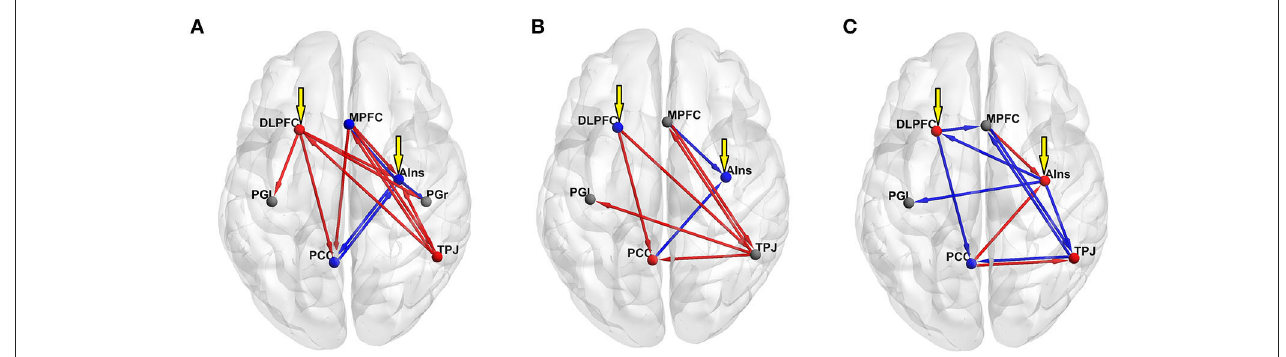
FIGURE 4 | Results of the DCM PEB analyses of the effect of adjective valence on effective connectivity (all effects with “positive evidence,” i.e., PP ≥ 0.75, are shown). Red spheres show decreased self-inhibition (i.e., disinhibition) of a region, whereas blue spheres show increased self-inhibition. Gray spheres mark regions with no significant effect. Red arrows show excitatory and blue arrows show inhibitory inputs. Yellow arrows show extrinsic input to the model. (A) group mean; (B) contrasting the POS group with the rest of the sample; (C) contrasting the NEG group with the rest of the